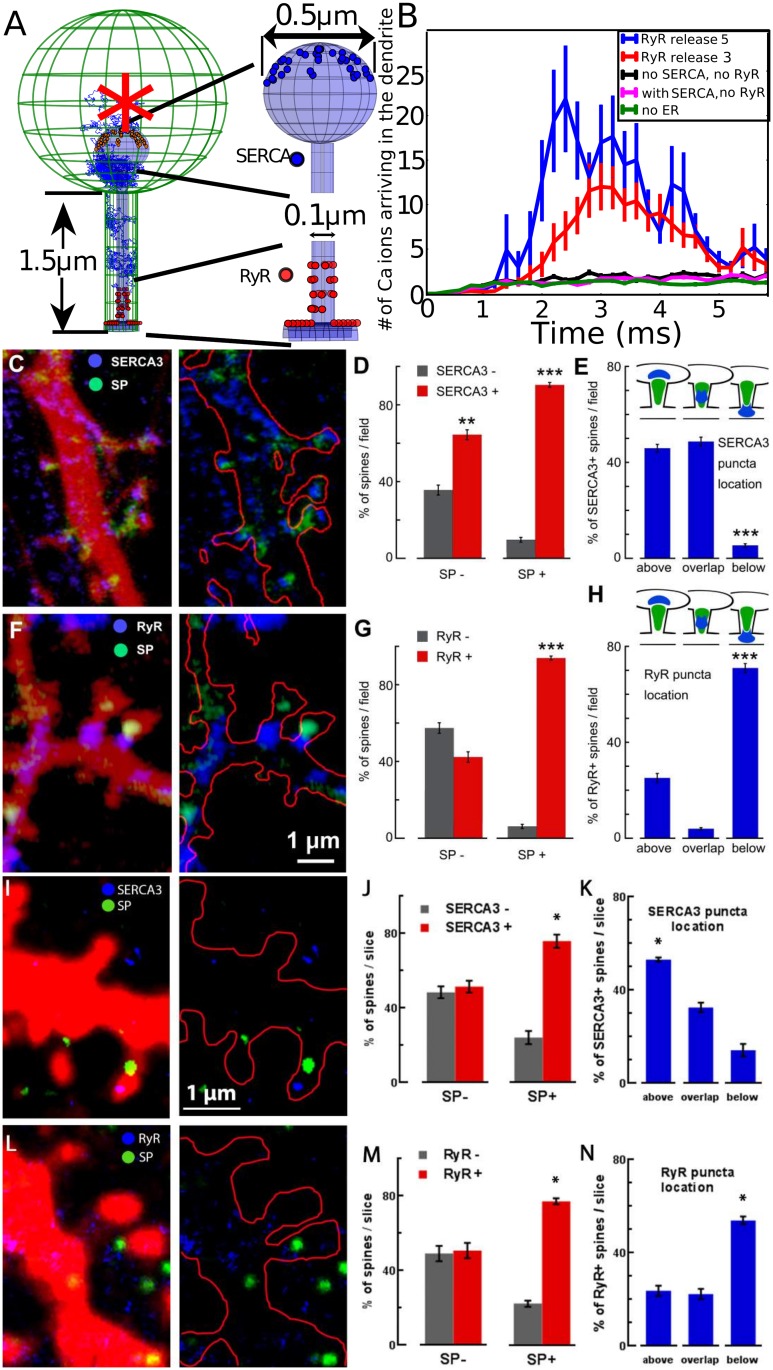
Modeling and simulation of Calcium dynamics to discover the distribution of RyR and SERCA in the SA.(A–B) Stochastic simulations of calcium ions; (G) model of a spine containing an SA with SERCA pumps and RyRs (right: magnifications show the distribution of 36 SERCA pumps in the upper hemisphere of the SA head and 36 RyRs located on the SA at the base, 12 on the shaft, and 24 in the neck, organized in four rings containing six randomly distributed receptors). Ions are initially released at the center of the head (red star). (B) Calcium ions arriving at the base of the dendrite following release in the head and release from RyRs (three and five ions per activated receptors). (C–H) Distributions of SERCA3 and RyRs in dendritic spines depend on the presence of SP puncta. (A) and (F) Cultured rat hippocampal neurons were cotransfected with DsRed (red color on the right panels and red contour on the left panel) and SP (green puncta) and immunstained against SERCA3 and RyR. In SP-occupied dendritic spines, top head locations of SERCA3 (blue staining in [D]) and basal locations of RyR (blue staining in [F]) are confirmed. Gray columns versus red columns compare the presence of SERCA3 immunostaining (D) and RyR immunostaining (G) in SP− (left bars) and SP+ (right bars) spines. Both the number of SERCA3− versus SERCA3+ as well as RyR− versus RyR+ spines is given in percent per standard field (N = 41 fields for [D] and 67 fields for [G]). Higher percentage of SERCA3+ and RyR+ spines in the SP+ groups (t probability < 0.01 for [D] and < 0.001 for [G]). (E) Specific location of SERCA3 in SP+ dendritic spines. Number of spines is given as percentages of total SP+ and SERCA3+ spines per standard field, which is taken as 100%. Fields are the same as in (D). Schematic representations of SERCA3 and SP puncta "typical" locations are shown on the top of the panel (E). Prevalence of SERCA3 puncta location above the SP puncta or overlapping with it (left and middle bars). (H) Location of RyR in SP+ dendritic spines. Again, the number of spines is given as percentages when the total SP+ and RyR+ spines per standard field is taken as 100%. Fields are the same as in (G). Schematic representations are shown on the top of the panel (H). Prevalence of RyR puncta located below the SP puncta (right bar). (I–N) Distributions of SERCA3 and RyR puncta in dendritic spines of hippocampal neurons from adult mouse brain slices also depend on the presence of SP puncta. (I) and (L) C57Bl6 mouse hippocampal neurons infected with AAV-hSynapsin-GFP virus (red color on the left panels and red contour on the right panels) and immunostained against SERCA3 or RyR and SP. Representative images show the top head locations of SERCA3 (blue staining in [I]) and basal locations of RyR (blue staining in [L]) in SP occupied dendritic spines (green staining in both [I] and [L]). (J) and (M) Gray versus red columns compare the presence of SERCA3 or RyR immunostainings in SP− (left bars) and SP+ (right bars) spines. Both numbers of SERCA3- versus SERCA3+ and RyR− versus RyR+ spines are given in percent of spines per brain slice (between 7 to 17 fields are analyzed for each sample for a total of 548 and 376 spines analyzed for SERCA3 and RyR conditions, respectively). There is significantly higher percentage of SERCA3+ and RyR+ spines in the SP+ groups (P < 0.05 for both conditions). (K) and (N) There is a significant prevalence of SERCA3 puncta location above SP puncta and RyR puncta location below SP puncta (one-way ANOVA test with multiple comparison, P < 0.05). The number of spines is given as percentages of the total SP+ and SERCA3/RyR+ spines. The fields of (K) and (N) are the same as in (J) and (M), respectively. Data of the panels D, E, G, H, J, K, M, and N are available in S1 Data. AAV, Adeno-associated virus; GFP, green fluorescent protein; RyR, Ryanodyne receptor; SA, spine apparatus; SERCA, sarco/ER calcium-ATPase; SP, synaptopodin.